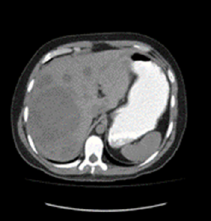
Figure 1. Baseline unenhanced CT scan showing multiple liver metastases.